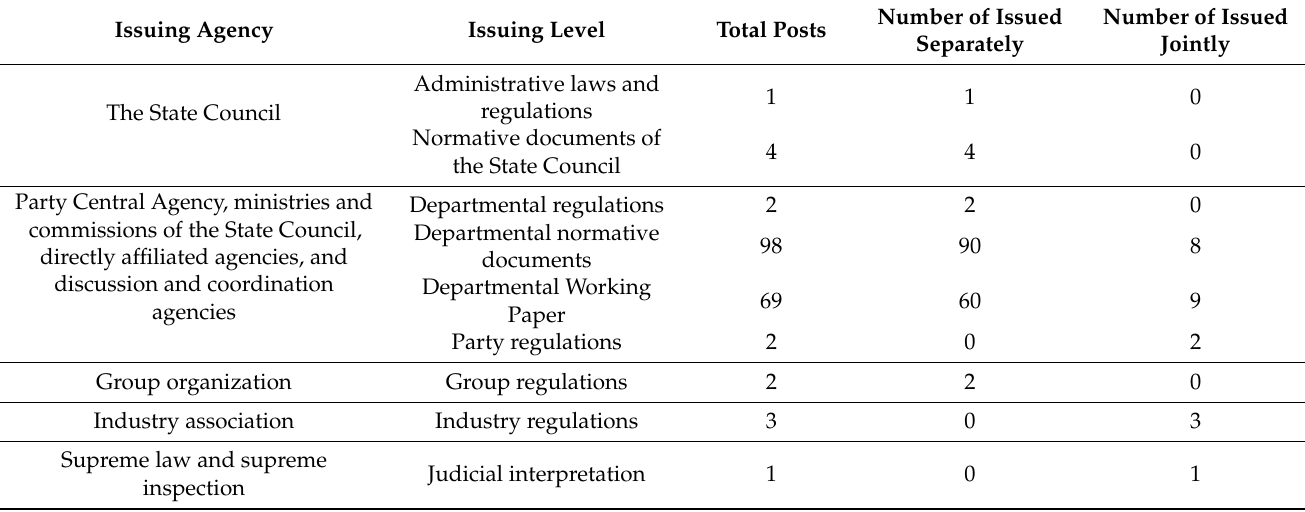
Table 1. Policy distribution during SARS epidemic.